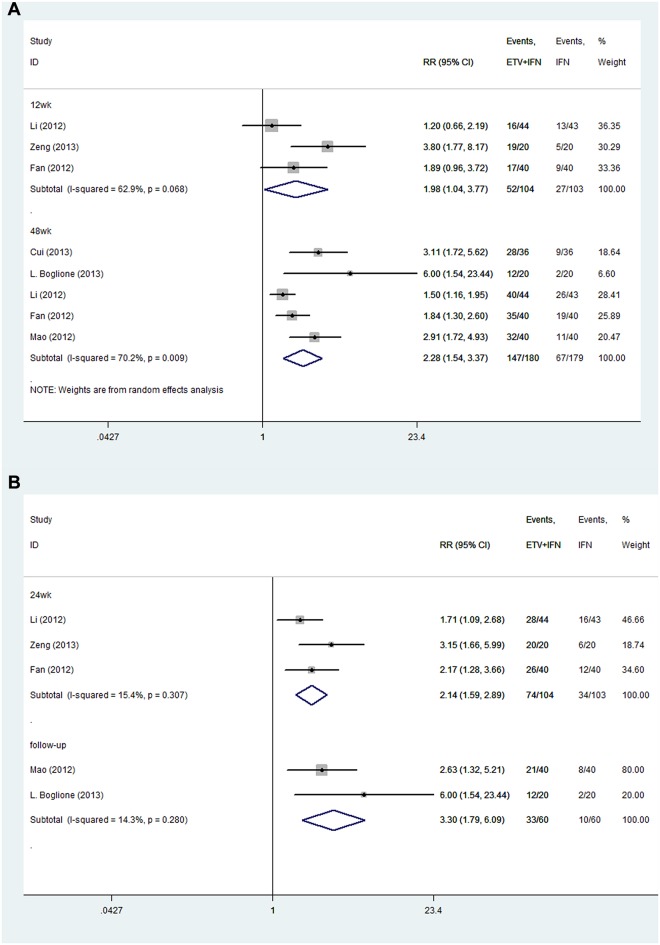
Forest Plot for Undetectable HBV DNA when IFN was used as the Control Group.(A) Forest plot for undetectable HBV DNA based on a random-effects model. (B) Forest plot for undetectable HBV DNA based on a fixed-effects model.